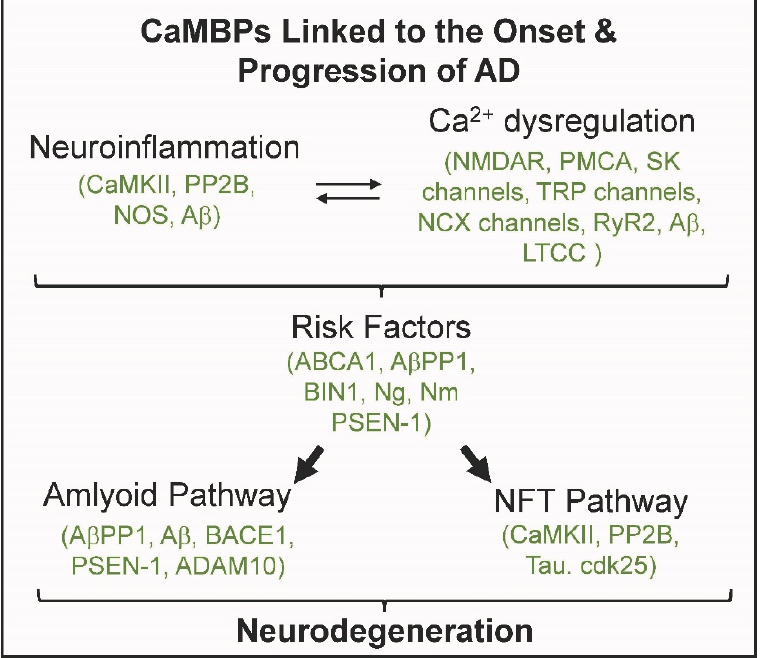
Figure 1. Experimentally validated calmodulin binding proteins (CaMBPs, Green) are involved in critical events in the onset and progression of Alzheimer’s disease. Table 1. Calmodulin Regulation of A β Receptors linked to Alzheimer’s Disease.